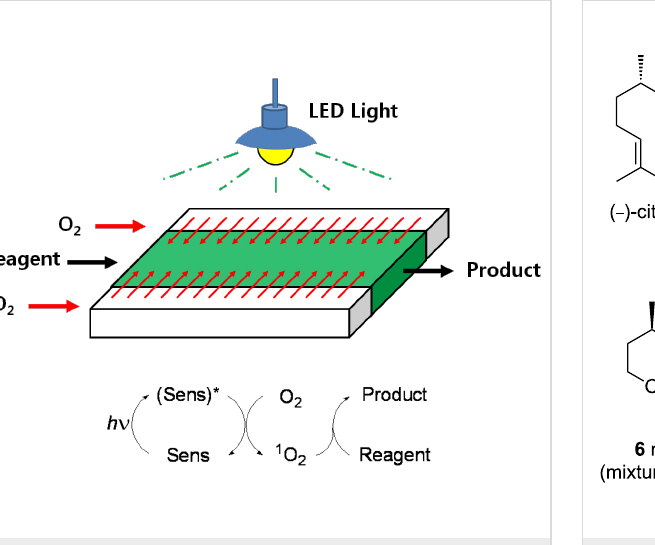
Figure 3: Photosensitized oxygenation in the triple-channel microreac- tor.